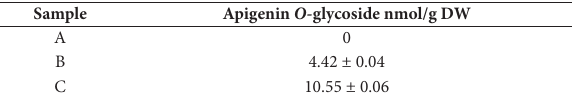
Table 3. Concentration of apigenin O -glycoside (nmol/g DW) in suspension cultures of A. vesicarius ssp. carniolicus ; A – plant cells grown on G48 medium, non-treated with apigenin (con- trol); B – plant cells grown on G48 medium, supplemented with 2 mg/mL apigenin; C – G48 medium, supplemented with 4 mg/mL